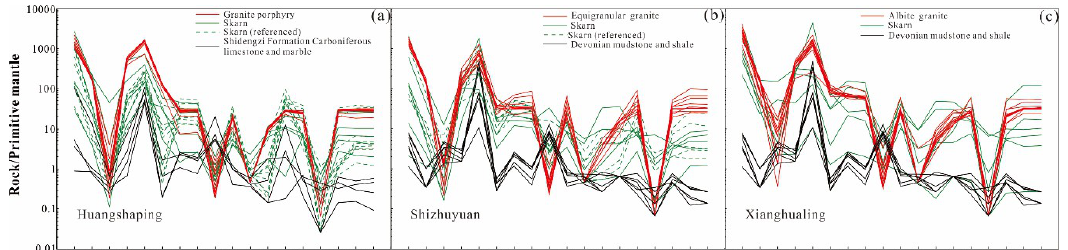
Figure 8. Primitive mantle-normalized trace element diagrams for granites, strata and skarns from the ( a ) Huangshaping, ( b ) Shizhuyuan and ( c ) Xianghualing deposit. Skarn data are from this study, and are reference from [25,31]. Strata composition of the Shidengzi Formation Carboniferous limestone are reference from [31], Devonian mudstone and shale composition are reference from [77]. Granite composition of the Huangshaping granite porphyry are reference from [24], Shizhuyuan equigranular biotite granite are reference from [44,68], Xianghualing albite granite are reference from [76]. Normalized values for primitive mantle are from [78].